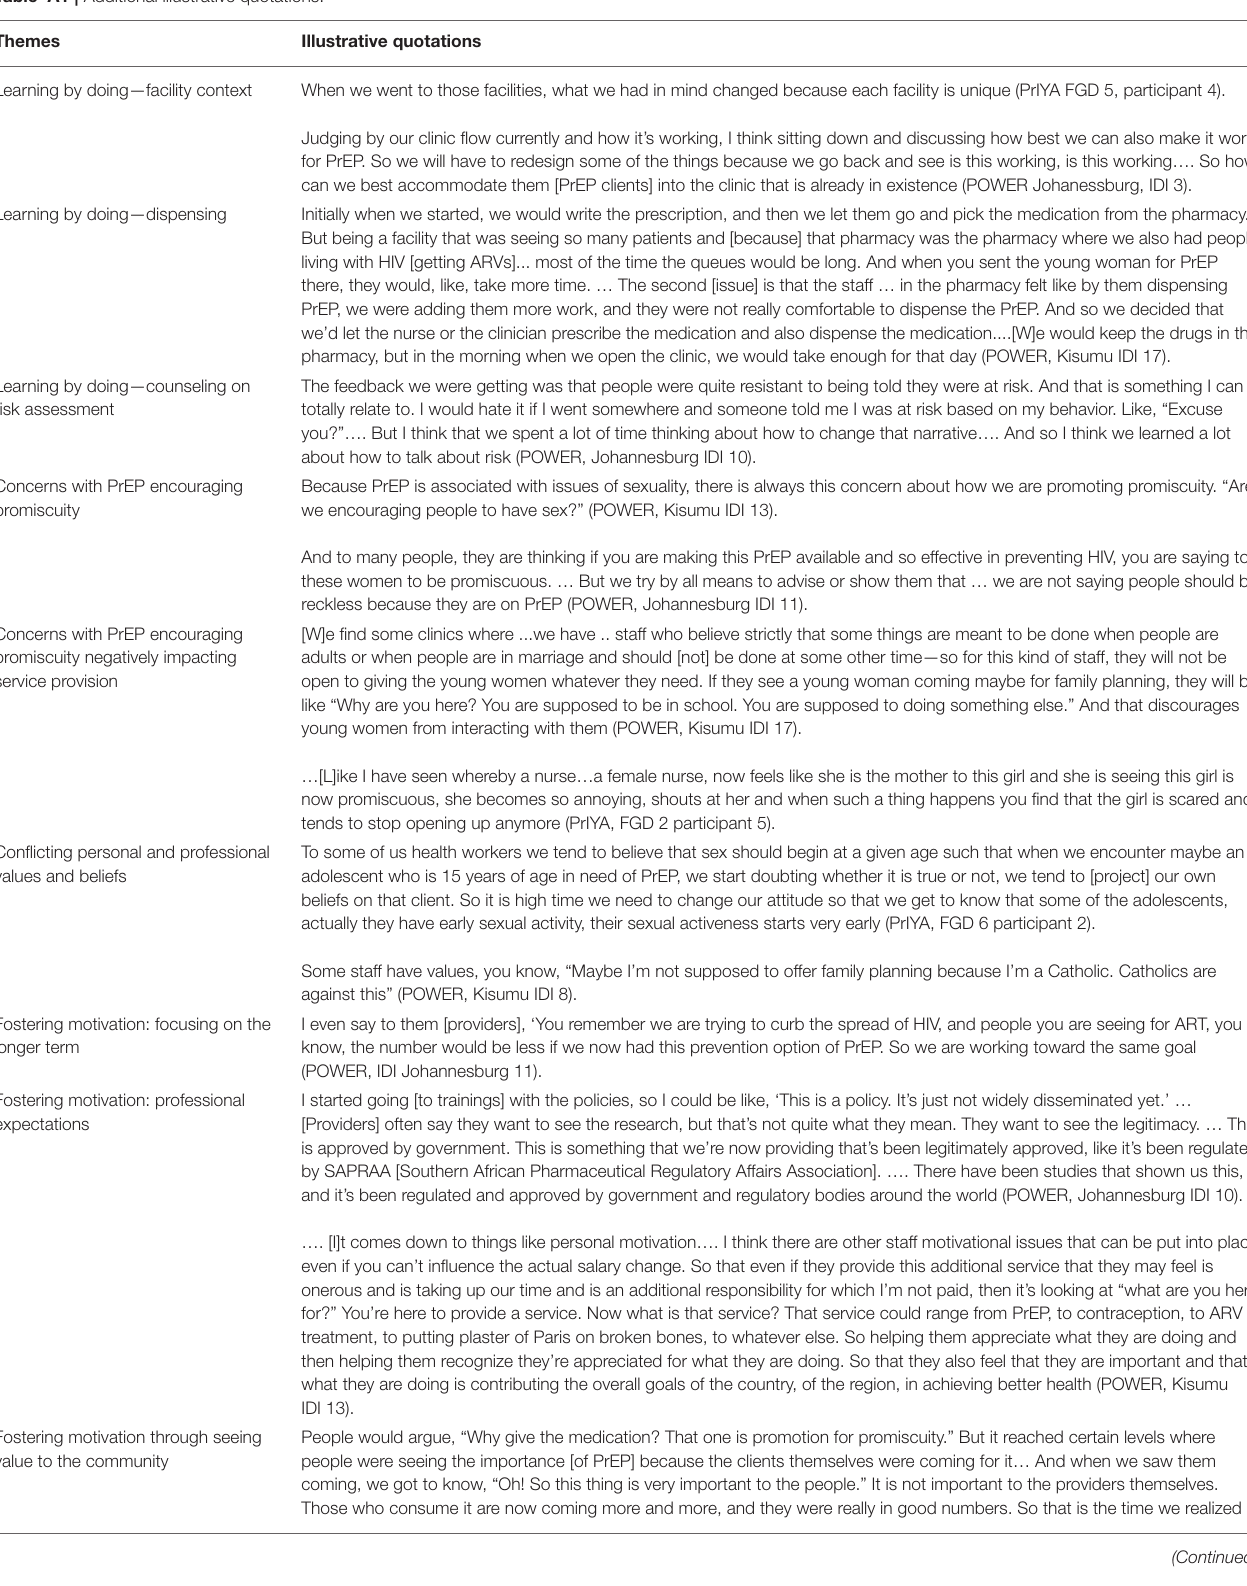
Table A1 | Additional illustrative